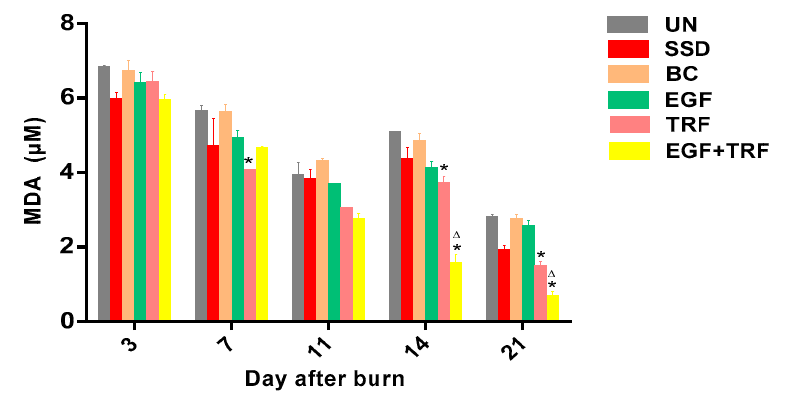
Figure 7. The malondialdehyde (MDA) content in all the groups over time post-burn. Data were expressed as mean ± S.E.M. * p < 0.05 compared with those of the UN group on the respective day and ∆ p < 0.05 compared with those of the SSD group on the respective day.